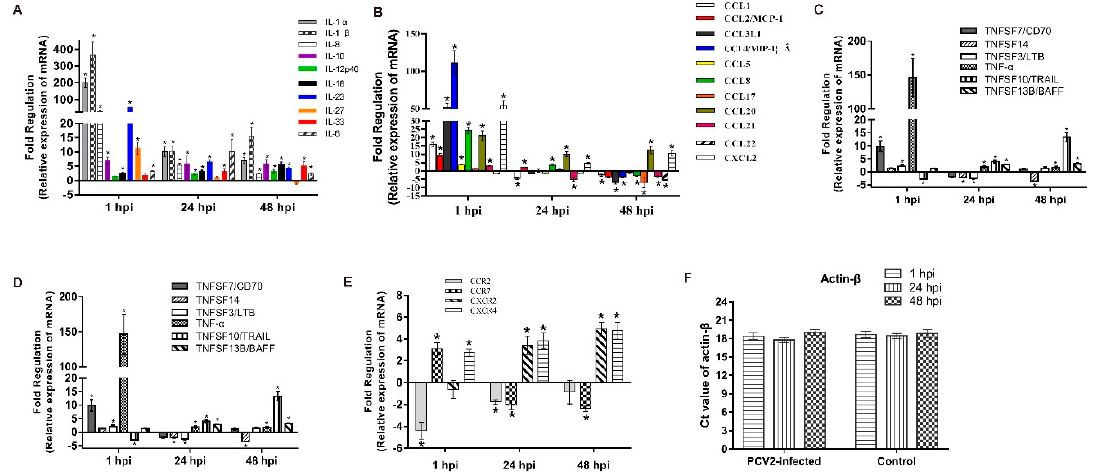
Figure 2. Changes in mRNA expression levels of inflammatory cytokines and receptors. PCR array assay system was used to assess the mRNA expression levels of interleukins ( A ), chemokines ( B ), tumor necrosis factor ( C ), colony-stimulating factors ( D ), and receptors of chemokine ( E ) in PAMs incubated with PCV2 and controls after 1, 24, and 48 h. The Ct value of actin- β in PCV2-infected and control groups ( F ). Fold regulation was obtained by comparing the relative expression intensity of PCV2-infected and uninfected control PAMs. Results are mean ± SE of three independent experiments. * represents p < 0.05.